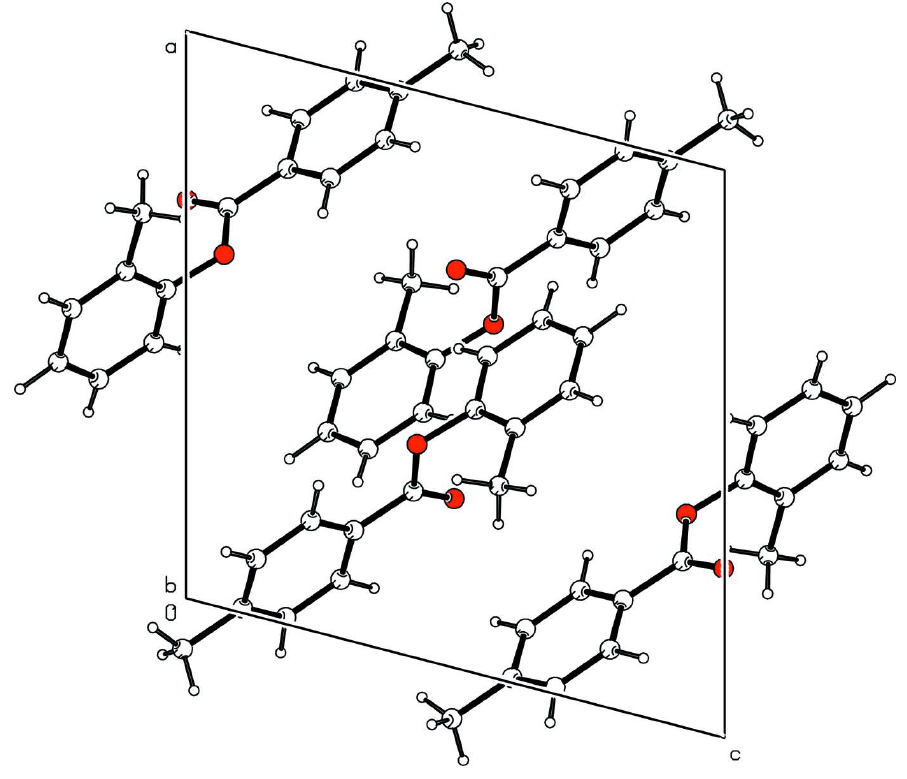
Figure 2 Molecular packing of the title